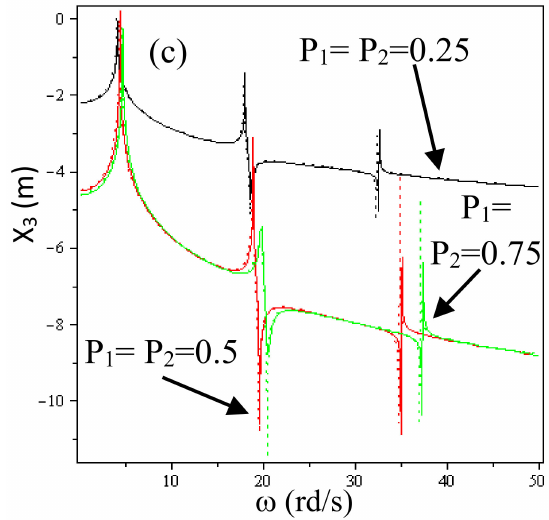
Figure 7. ( a ). Displacement x 1 versus the circular natural frequency ω . Superposition of the solution by the RPM approach (____) and the exact solution (—-). ( b ). Displacement x 2 versus the circular natural frequency ω . Superposition of the solution by the RPM approach (____) and the exact solution (—-). ( c ). Displacement x 3 versus the circular natural frequency ω . Superposition of the solution by the RPM approach (____) and the exact solution (—-).